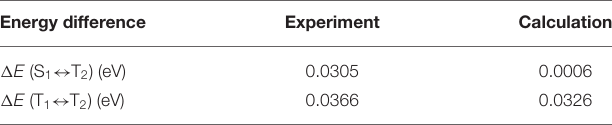
TABLE 4 | Energy differences of T 1 and T 2 [ 1 E (T 1 ↔ T 2 )] and S 1 and T 2 [ 1 E